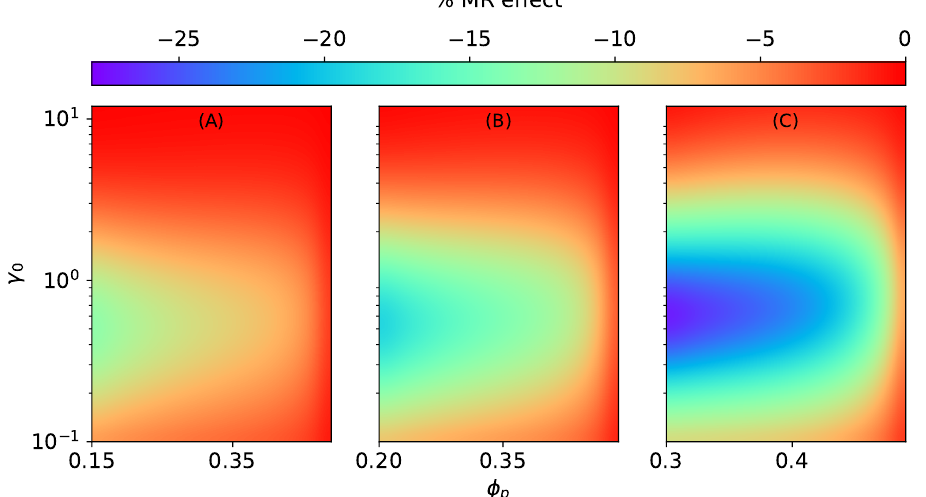
Figure 9. The magneto-rheological effect ( K ⊥ ) stretched perpendicular to the field direction at constant | (cid:126) H 0 | = 470 kA/m, G m = 17 kPa. ( A ) φ = 0.15, ( B ) φ = 0.2, ( C ) φ =